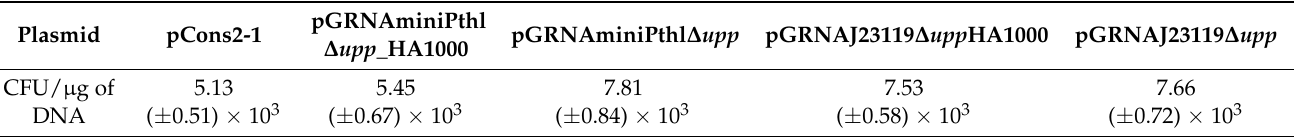
Table 1. Transformation efficiencies of strain CAS1 with pCons2-1 , pGRNAminiPthl Δ upp _HA1000, pGRNAminiPthl Δ upp, pGRNAJ23119 Δ upp HA1000, and pGRNAJ23119 Δ upp. Values are expressed in number of transformants per microgram DNA. Mean values and standard deviations from three independent experiments are given. A total of 0.5 μ g of DNA was used in each experiment.